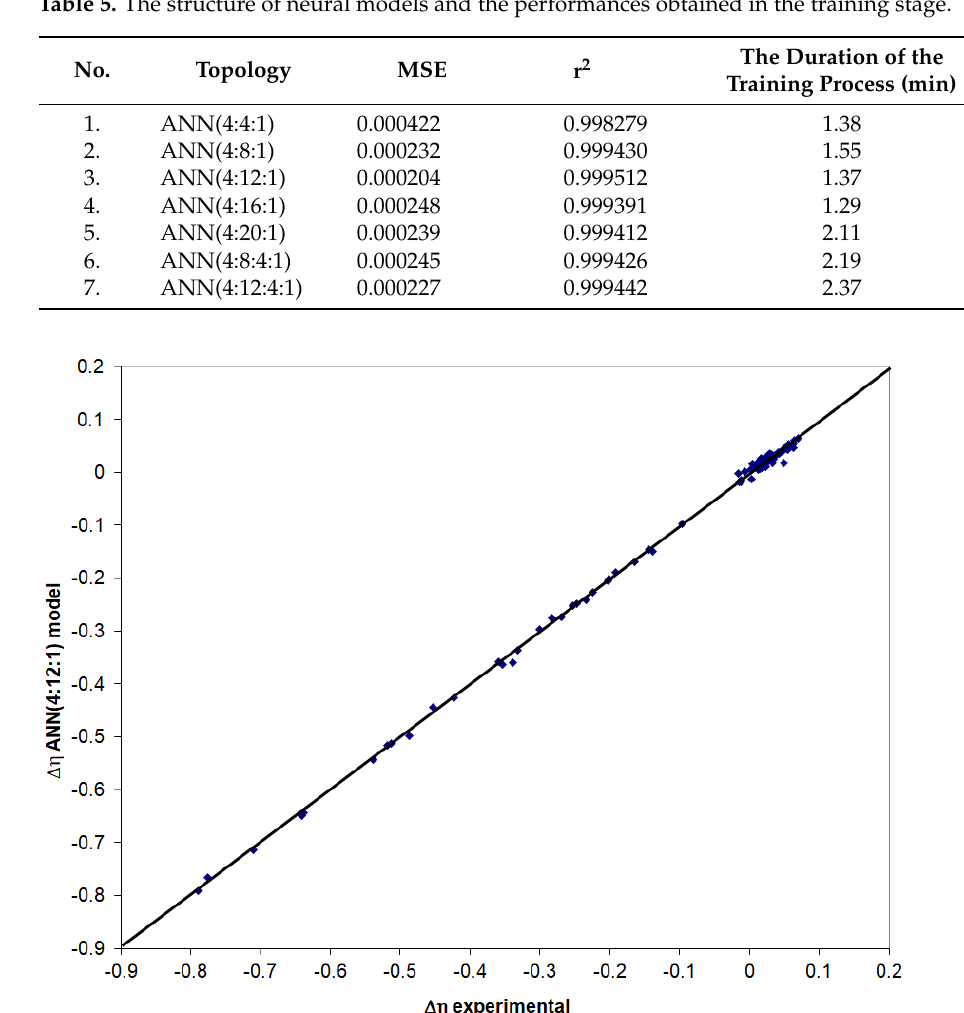
Figure 6. Evaluation of the ANN(4:12:1) model in the testing stage. The calculated standard deviation for the ANN(4:12:1) model in the testing stage with relation (5) is 0.0067, and the correlation coefficient is